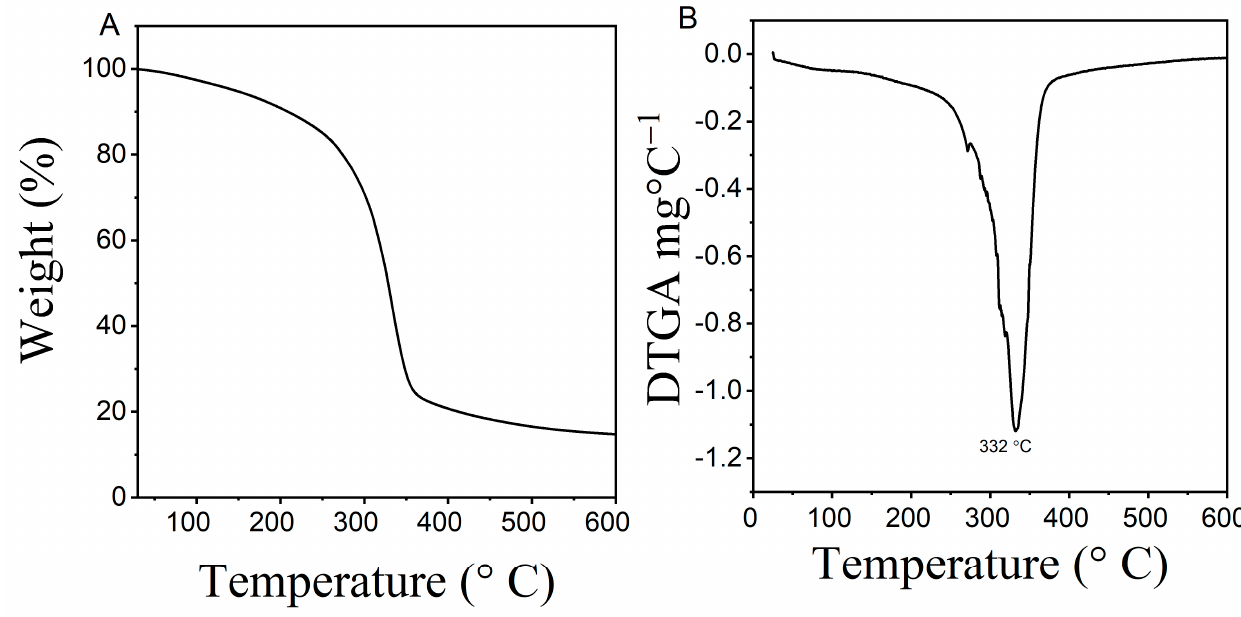
Figure 8. ( A ) TGA, and ( B ) DTGA thermograms for taro peel starch film.